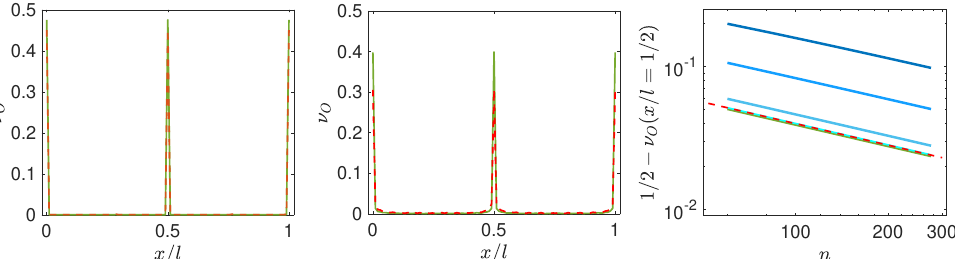
Figure 12: Distribution of operator evolution at type I exceptional point with ϕ = 5 (left) and ϕ = 1 (middle) in (46). The initial positions of operator are uniformly distributed on the line. We choose φ = π/ 2 in both cases. The driving steps are n = 4 3 (red dashed line) and n = 4 4 (green solid line). Right: The scaling behavior ( x / l = 1 / 2 ) for ϕ = 1,2,3,4,5 (solid lines from top to bottom). The red of 1 / 2 − ν O dashed line is the analytical result in